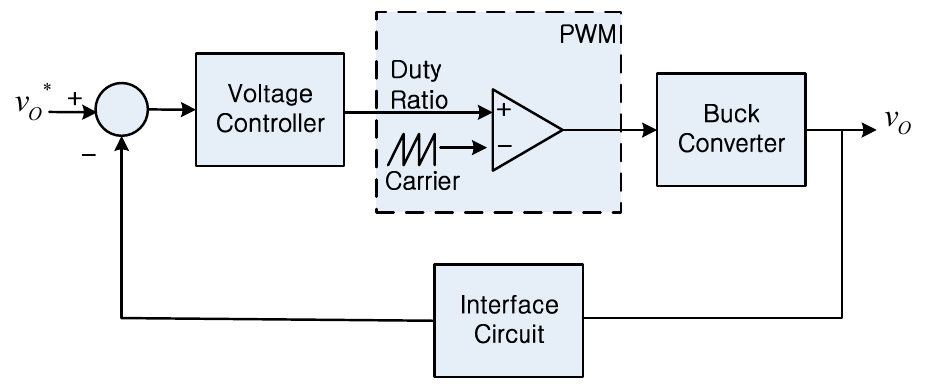
Figure 6. Control block diagram of a buck converter.